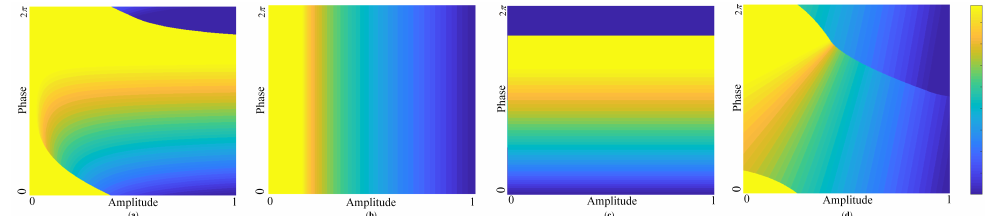
Figure 7. The mapping of vegetation height and coherence in the amplitude-phase plane using least distance criterion with ( a ) the Euclidean distance, ( b ) the amplitude distance, ( c ) the phase distance and ( d ) the generalized distance.